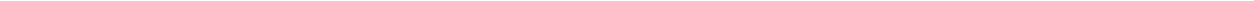
Fig. 1 ER- and mitochondria-targeted US9 inhibits the MAVS- and STING-mediated IFN- β response. a Schematic representation of the HCMV genome and US9. MLS, mitochondrial localization signal. b US9 is localized to the ER and the mitochondria. Cytosolic/ER/mitochondrial fractions isolated from HA-US9-GFP-expressing HEK293T cells were immunoblotted with anti-GFP antibody. C/ER, cytosolic/ER fraction; Mito, mitochondrial fraction; Total, total cell lysate. Anti-Tom20, anti-Tubulin, and anti-PDI were used as the mitochondrial, cytosolic, and ER markers, respectively. c IFA of US9 subcellular localization. HEK293T cells expressing HA-US9-GFP were stained with an ER (anti-PDI) or mitochondrial marker (anti-Tom20). The nuclei were stained with DAPI. Scale bars, 10 μ m. d US9 undergoes dimerization. Cell lysates from US9-GFP- and HA-US9-expressing HEK293T cells were immunoprecipitated with anti-GFP, and then immunoblotted with the indicated antibodies. e US9 forms high-molecular-weight oligomers. The cell extracts from HEK293T cells with or without HA-US9-GFP were resolved by SDD-AGE (top) and SDS-PAGE (bottom). f US9 undergoes ubiquitination. HEK293T cells expressing HA-US9-GFP were immunoprecipitated with anti-HA, and immunoblotted with anti-Ubiquitin. g US9 inhibits RNA- and DNA-induced IFN- β induction. HeLa or HEK293T cells were transfected with poly(I:C) (20 μ g ml − 1 ) or salmon sperm DNA (dsDNA) (2 μ g ml − 1 ) for 12 h. IFN- β mRNA levels were analyzed by RT-PCR. Right graph, quanti fi cation of IFN- β mRNA expression levels was shown in the graph. * P < 0.005 (Student ’ s t test). h US9 impedes MAVS-mediated IFN- β expression. HEK293T cells were transfected with the indicated plasmids and incubated for 21 h. Right graph, quanti fi cation of IFN- β mRNA levels was shown in the graph. * P < 0.005 (Student ’ s t test). i US9 suppresses STING – TBK1-induced IFN- β mRNA expression. HEK293T cells expressing STING-Myc and Flag-TBK1 were transfected mock or HA-US9-GFP. Right graph, quanti fi cation of IFN- β mRNA levels was shown in the graph. * P < 0.005 (Student ’ s t test). j US9 blocks MAVS- and STING-induced IFN- β production. HEK293T or HFF cells were transfected with MAVS or STING-Myc in the absence or presence of HA-US9-GFP, followed by transfection with salmon sperm DNA (1 μ g ml − 1 ). After 36 h incubation, IFN- β levels were analyzed by ELISA assay. * P < 0.005 (Student ’ s t test). Data are representative of three independent experiments and are presented as mean ± standard deviation (mean ± s.d.) in g , h , i , and